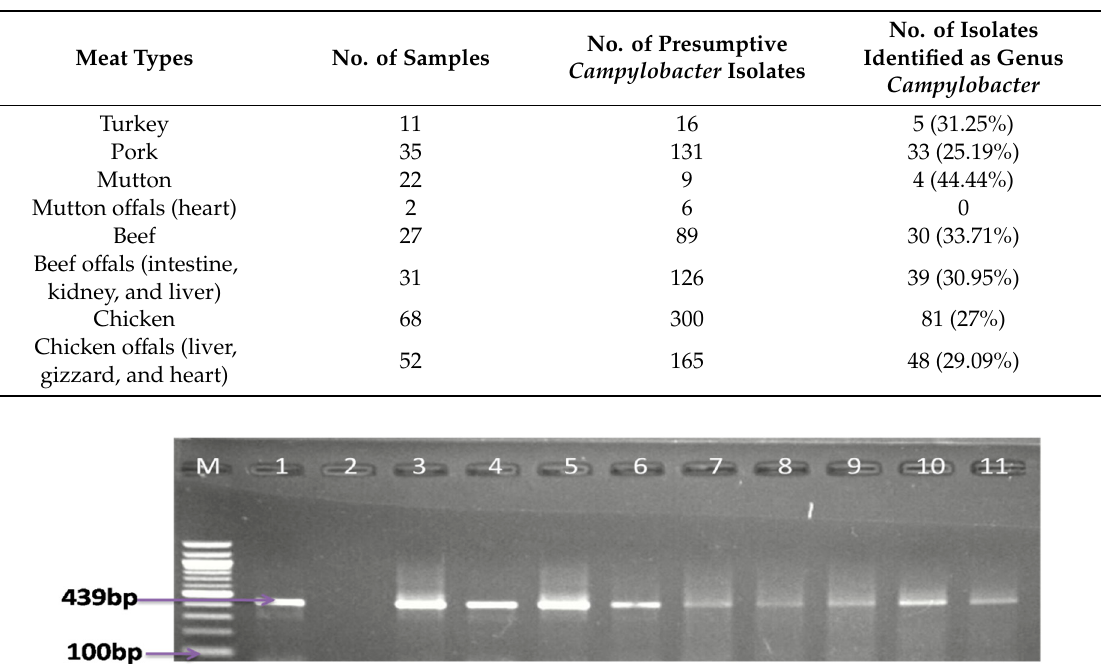
Table 1. Number of Campylobacter isolates identified in various meat types.